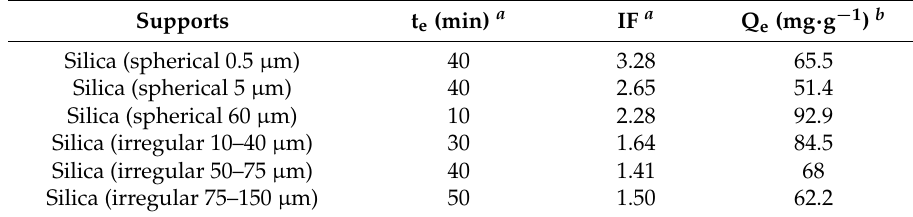
Table 2. Adsorption equilibrium time (t e (min)), imprinting factor (IF) and equilibrium adsorption capacity (Q e (mg · g − 1 )) of different MIPs on their corresponding